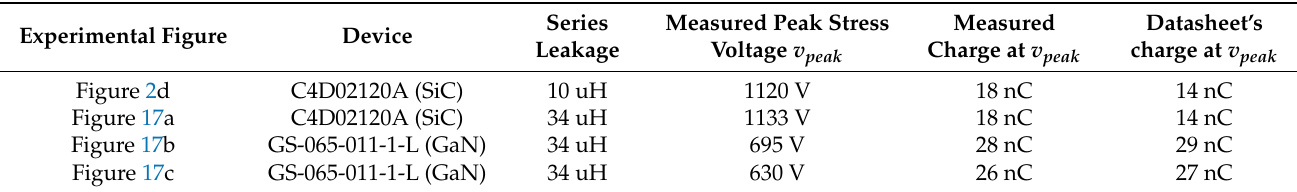
Table 3. Experimental measurement of rectifier peak stress and